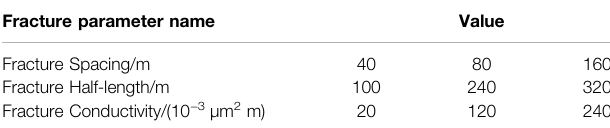
TABLE 2 | Initial fracturing parameters of depleted development